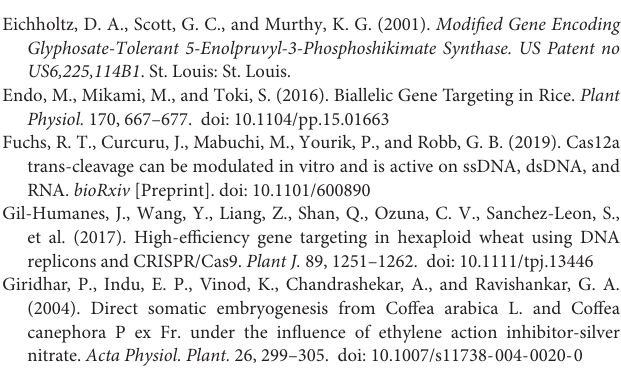
Supplementary Figure 1 | Agrobacterium -mediated transformation protocol used in this work. Supplementary Figure 2 | Effects of polyamine treatment on the GT efficiency using the multireplicon pMR01. Supplementary Figure 3 | Effects of AgNO 3 treatment on purple spot numbers and purple shoot regeneration. Supplementary Figure 4 | Map of SpCas9 and LbCas12a binding sites at the SlANT1 locus. Supplementary Figure 5 | Editing performance of the T-DNA and replicon-based SpCas9 and LbCas12a GT tools at various sites of the SlANT1 locus. Supplementary Figure 6 | Representative indel mutation traces of the GT constructs revealed from ICE Synthego analysis. Supplementary Figure 7 | Representative SlANT1 GT events obtained from the study. Supplementary Figure 8 | Thin slice cotyledon explants for the assessment of editing efficiencies by targeted deep sequencing at 10 dpt. Supplementary Figure 9 | Diagram showing the strategy for replacement of two amino acids of the SlEPSPS1 gene. Supplementary Figure 10 | Gene targeting constructs for editing the SlHKT1;2 and SlEPSPS1. Supplementary Figure 11 | ICE Synthego decomposition showing the TIPS allele frequency from the transformant H281.82. Supplementary Figure 12 | Representative transformants obtained using the GT tools for TIPS allele replacement. Supplementary Table 1 | Impacts of SCR7 on GT efficiency. Supplementary Table 2 | Gene targeting performance revealed from the treatment of KU0060648 and NU7441. Supplementary Table 3 | Gene targeting efficiency obtained from polyamine treatment. Supplementary Table 4 | Gene targeting efficiency of the AgNO3 and mock treatments of pMR01. Supplementary Table 5 | Sequences and primers used in this study. Supplementary Data 1 | Sequences used in the